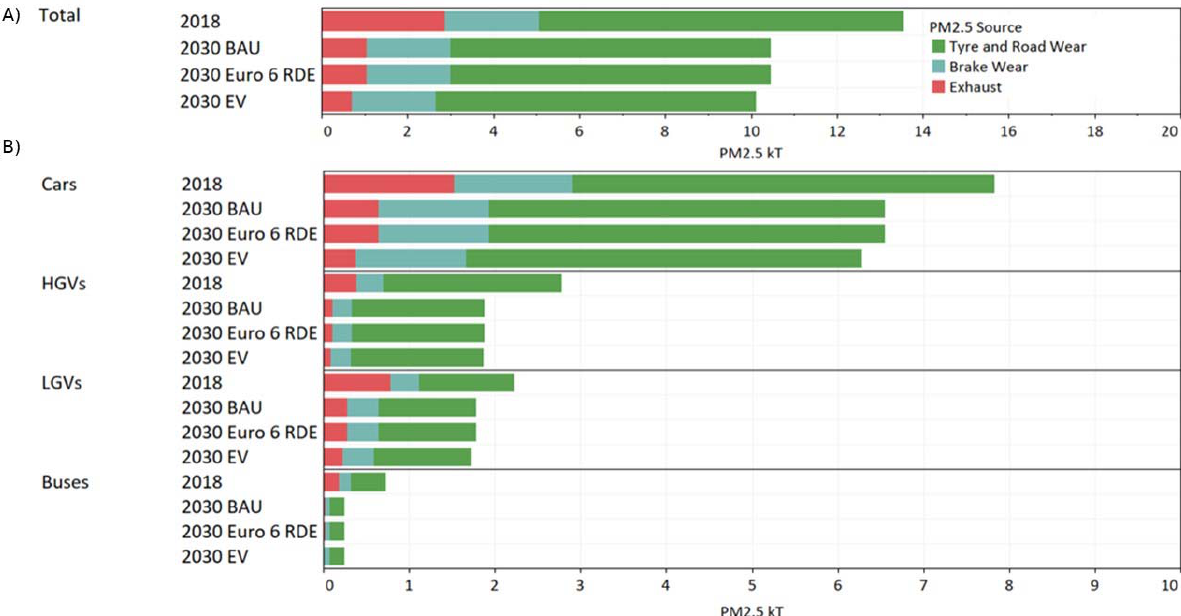
Figure 3. ( A ) Total fleet emissions of PM 2.5 for each scenario in 2030. ( B ) PM 2.5 emissions given by vehicle type, where colour shows the emission source: tyre and road wear (categorised together in BRUTAL), brake wear, and exhaust.